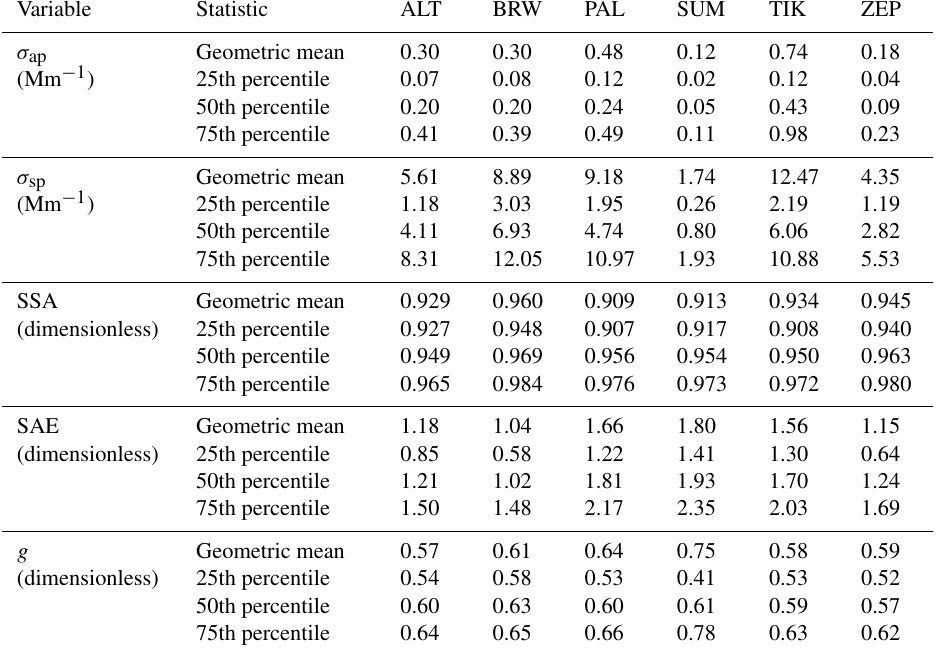
Table 2. Statistics of aerosol optical properties at six Arctic monitoring sites, including geometric means, medians, and interquartile spread of absorption coefficient ( σ ap ) at 550nm, scattering coefficient ( σ sp ) at 550nm, single-scattering albedo (SSA) at 550nm, and scattering Ångström exponent (SAE) at 450 and 700nm. Percentile statistics are based on hourly